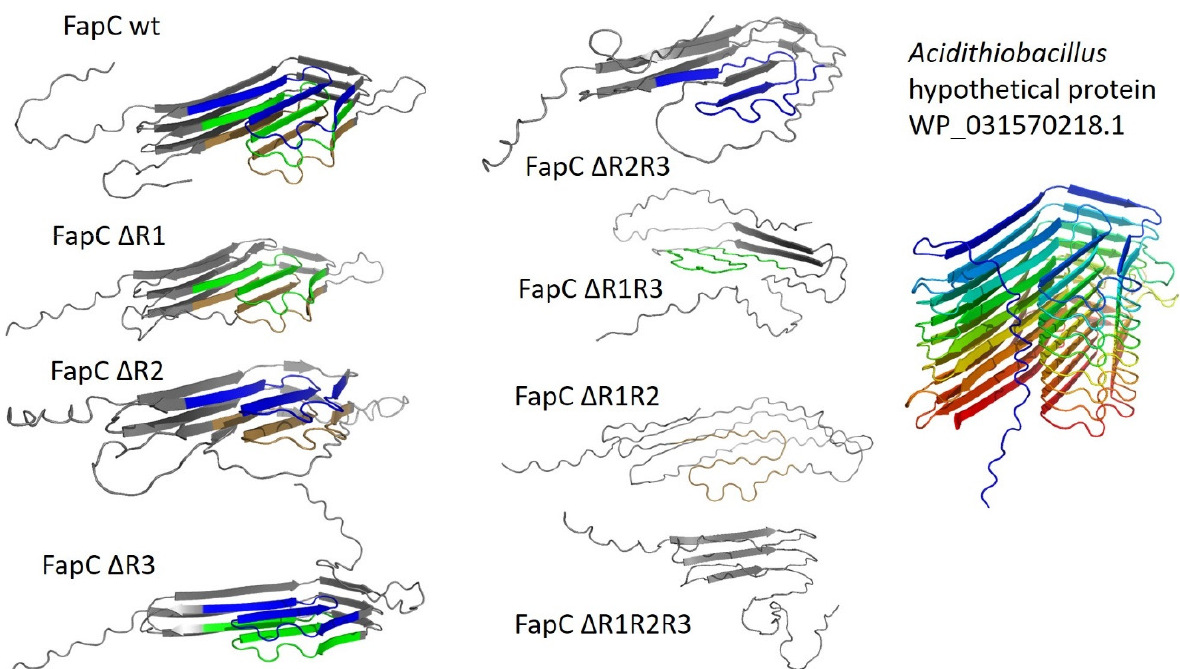
Figure 5. AlphaFold predictions of the structures of FapC imperfect repeats. The two leftmost columns show different FapC UK4 constructs where one or more of the three repeats R1–R3 have been removed (nomenclature and numbering as in [65]), and the structure of the resulting sequence was analyzed by AlphaFold. The rightmost column shows the predicted structure of a FapC homologue from Acidothiobacillus which has 8 imperfect repeats, each of which forms a layer in the ensuing β - helix structure. Note the similar cross-sections of FapC wildtype and the Acidothiobacillus protein.